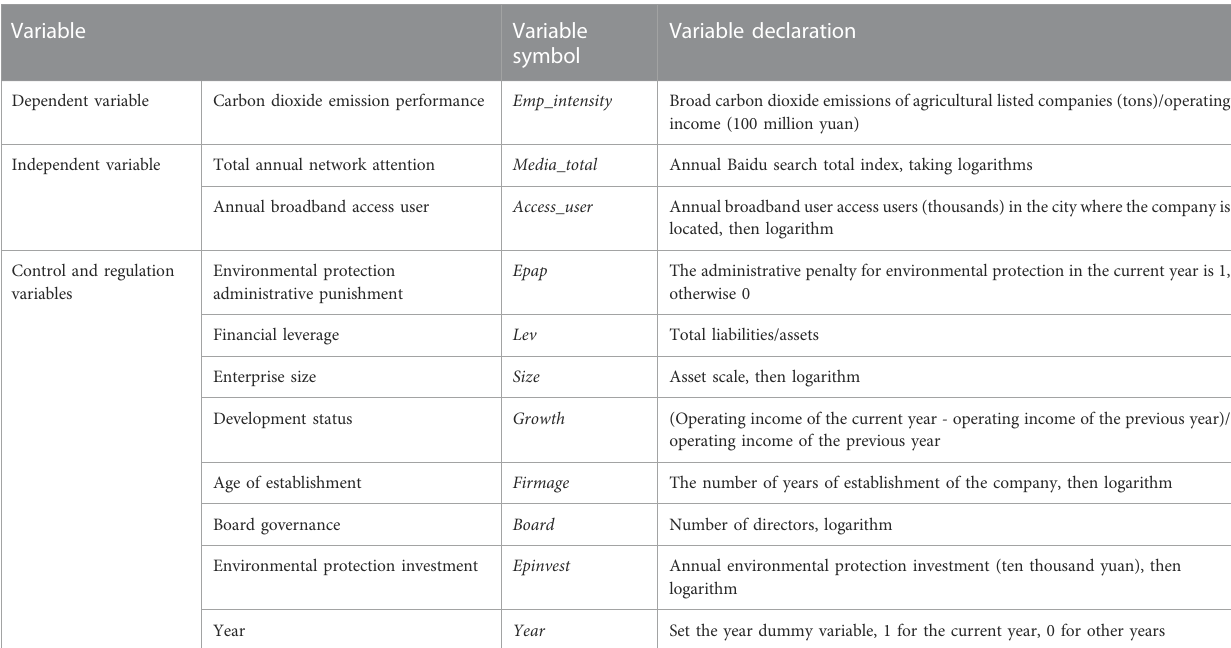
TABLE 1 Variable de fi nitions.